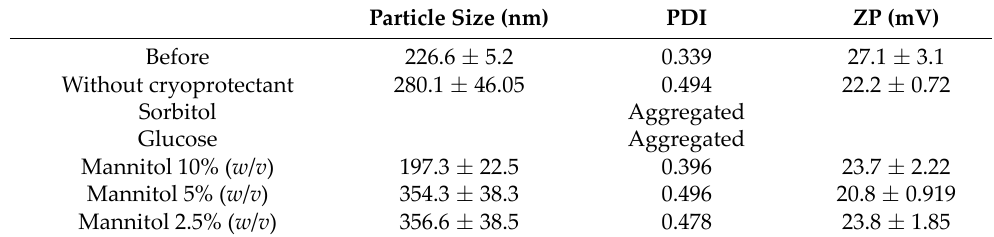
Table 4. Effect of the selected cryoprotectants on the NP freeze-drying process.